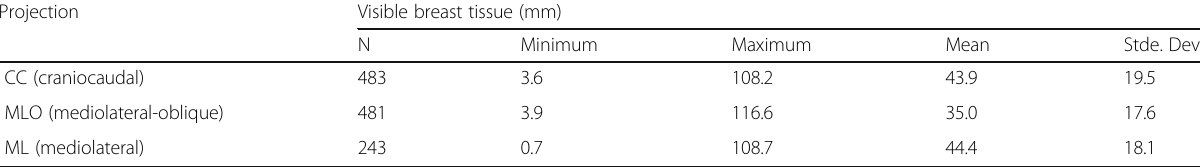
Table 3 Visible breast tissue without breast implant superimposition for all projections assessed Projection